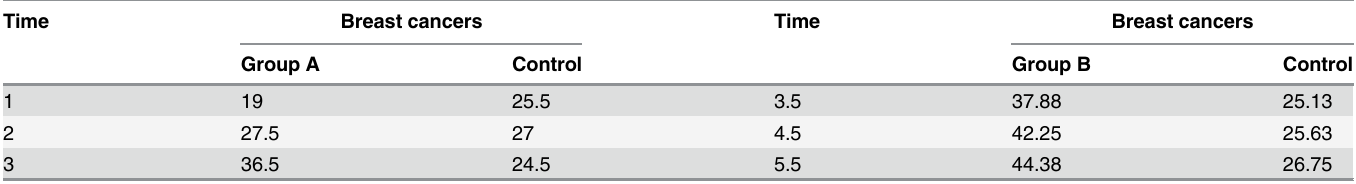
in columns 3 and 6 in Table 1 by 0.85. Table 3. (Scenario 3) The number of breast cancer cases in the intervention group for the short term users (Group A) and long term users (Group B). Time